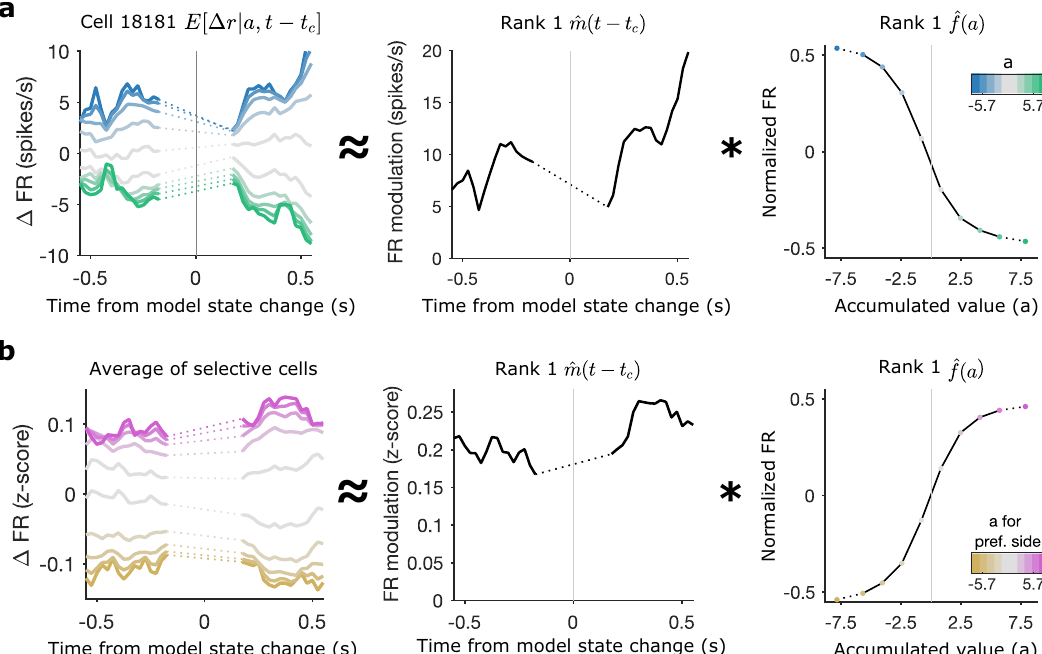
Fig. 5 Stable tuning curve captures responses before and after model state changes. a Example cell tuning map triggered on model-predicted state changes with rank 1 approximation derived temporal modulation and evidence tuning. Data is excluded from the 300 ms around the state change where the accumulated value distribution is too narrow to estimate tuning (dotted lines). b Average of all pre-movement side-selective cells' tuning maps computed with z scored fi ring rates and triggered on model-predicted state changes along with rank 1 approximation derived temporal modulation and evidence tuning for the average map. Source data are provided as a Source Data fi Fig. 5a explains 98.9% of the variance in the tuning map and the average variance explained for all selective cells is 84.9% ± 9.8%.